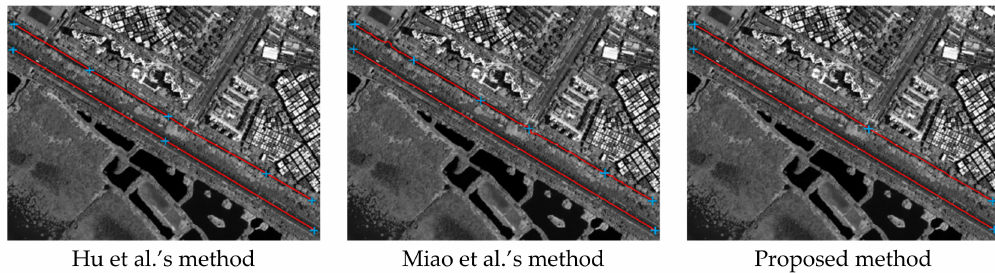
Figure 7. Comparison of the results provided by different road extraction methods for a QuickBird image.